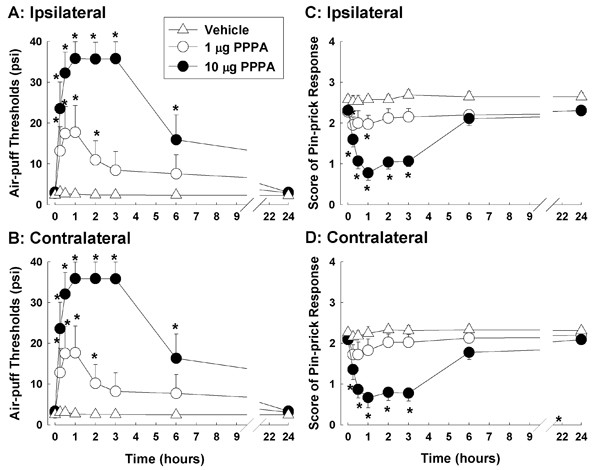
The antinociceptive effects of PPPA in rats with compression of the trigeminal nerve root. The effects of PPPA, a competitive NR2A antagonist, on mechanical allodynia (A, B) and hyperalgesia (C, D) in rats with compression of the trigeminal nerve root (n = 8 in each treatment group). The intracisternal administration of vehicle did not affect air-puff thresholds in either ipsilateral or contralateral side. However, 1 or 10 μg injections of PPPA significantly increased the air-puff threshold in a dose-dependent manner both ipsilateral (A) and contralateral (B) to the compression of the trigeminal nerve root. The anti-allodynic effects of PPPA were maintained for one hour after a 1 μg injection of PPPA and six hours after a 10 μg dose of PPPA. The intracisternal administration of 1 or 10 μg of PPPA also significantly decreased the pin-prick scores on both sides (C, D). The anti-hyperalgesic effects of PPPA had completely recovered by six hours after the 10 μg PPPA injection. *P < 0.05, vehicle-vs. PPPA-treated groups.